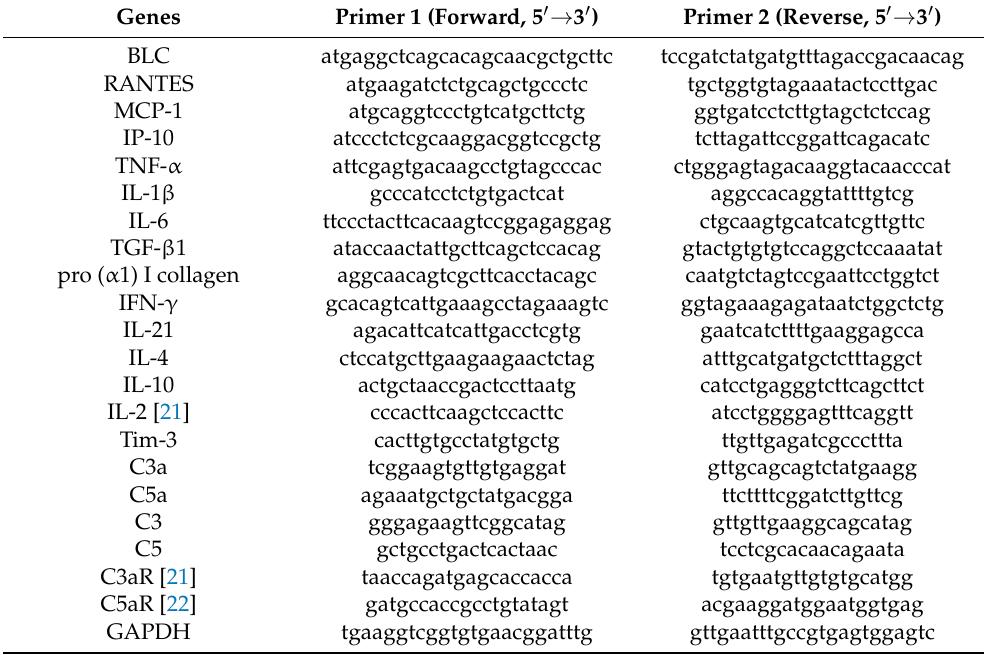
Table 1. Primer sequences used for qPCR.